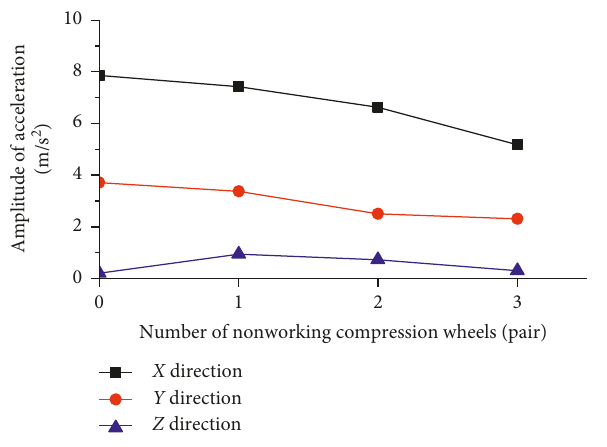
Figure 15: Amplitude of displacement vs. the number of non- working compression wheels of the inspection vehicle.